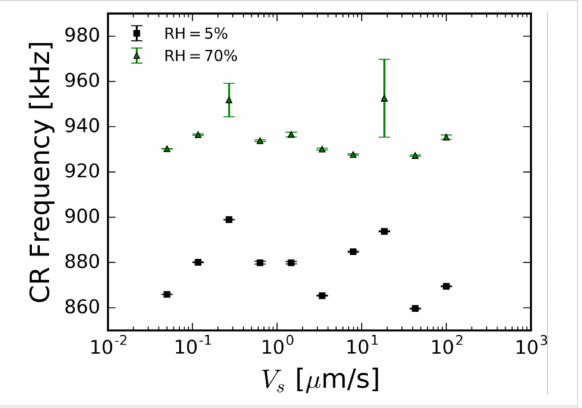
Figure 6: The measured in-contact resonance frequencies of an AFM cantilever as functions of the dynamic scan speed on a mica surface at 100 nN force set-point and 5% and 70% relative humidity. No scan speed-related phenomena are observed. Error bars represent one standard deviation from the mean.